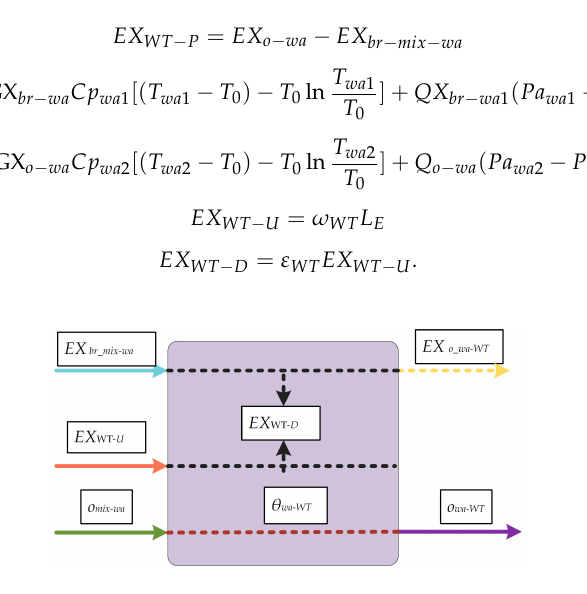
Figure A6. Process flowsheets of WT .